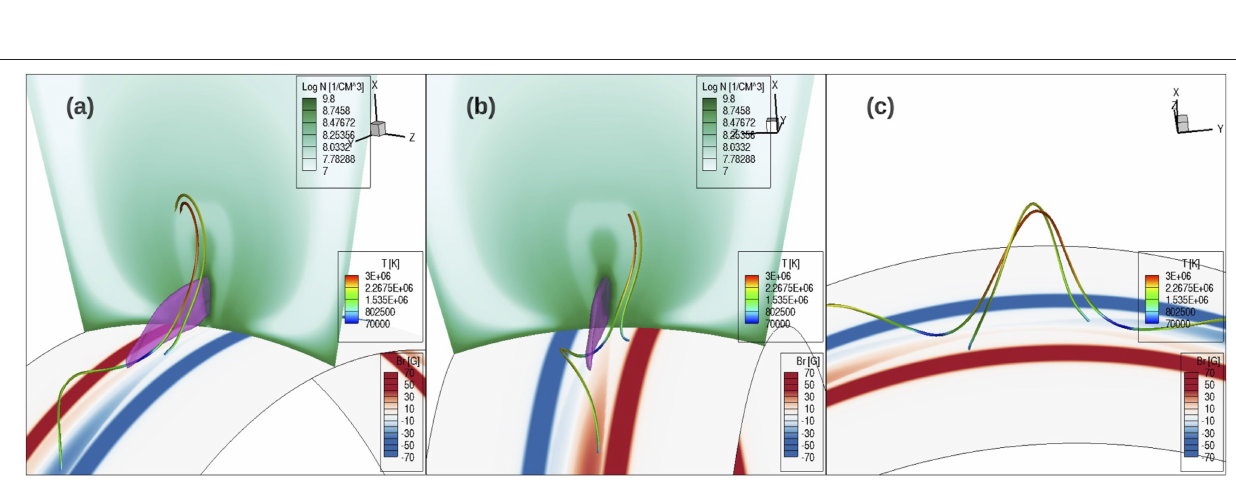
Frontiers in Astronomy and Space Sciences | www.frontiersin.org